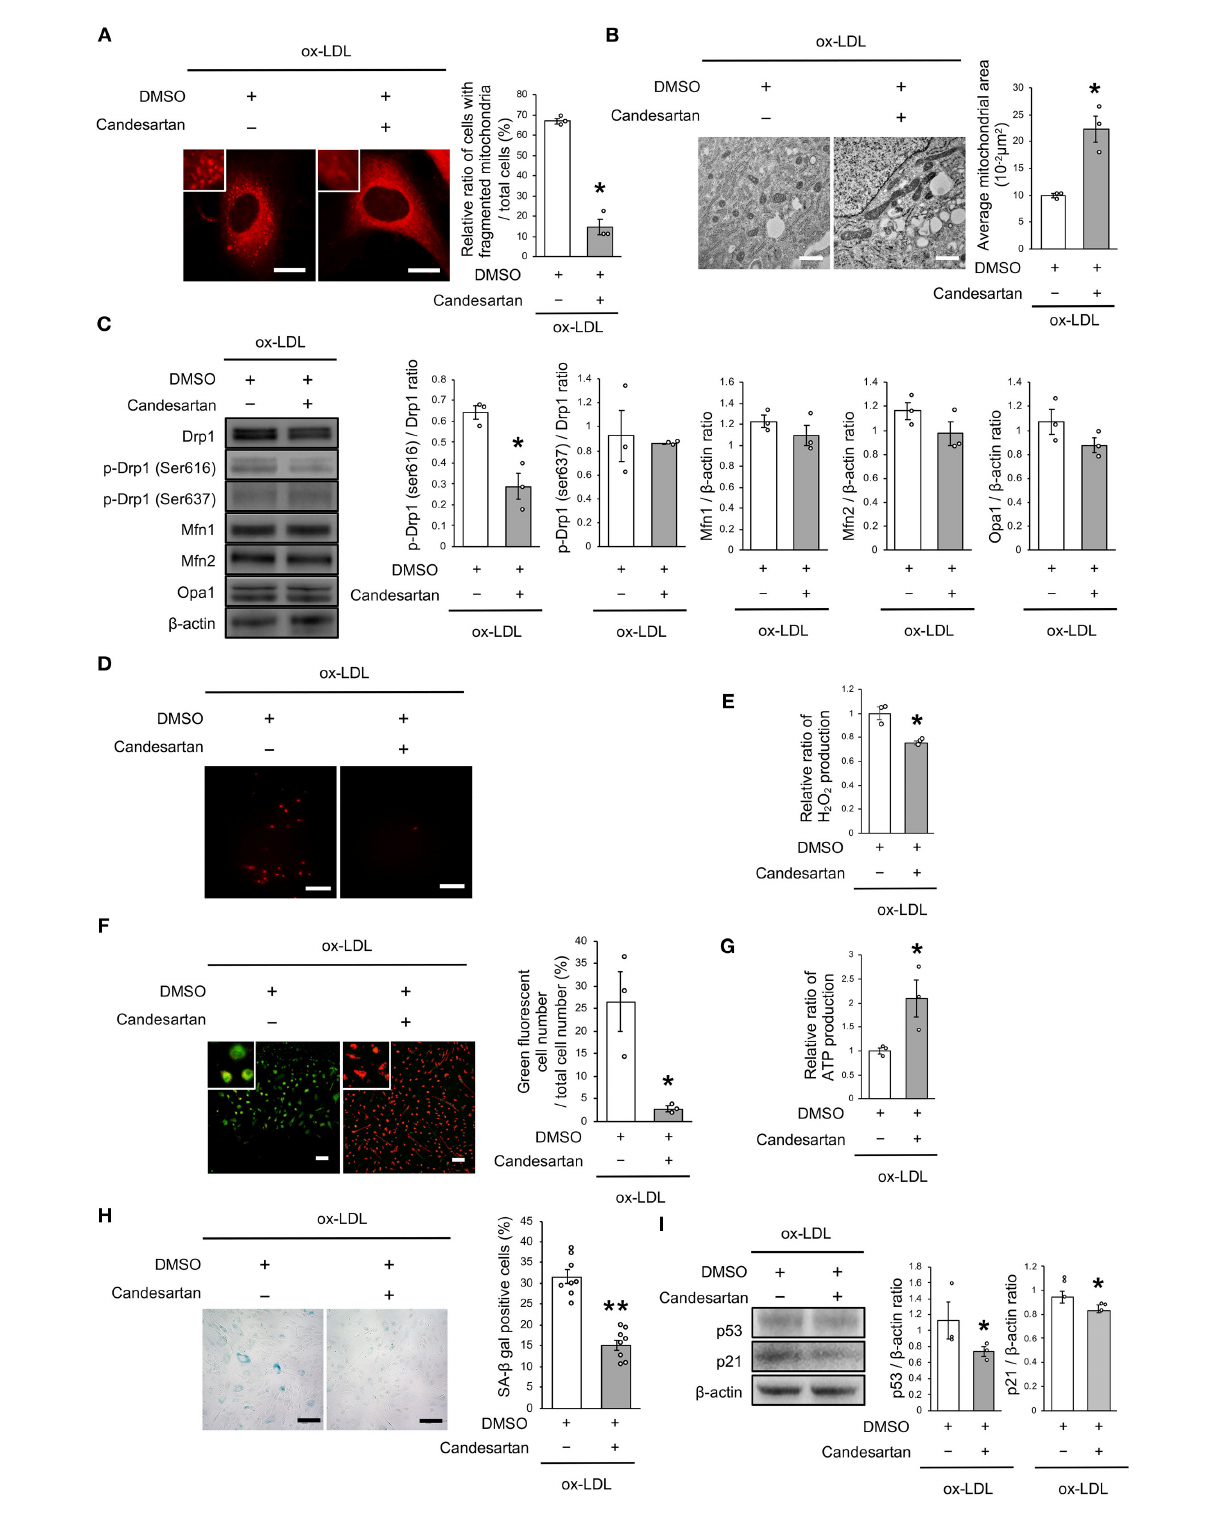
FIGURE 3 | AT1R inhibition retarded excessive mitochondrial fission, ROS production, mitochondrial dysfunction, and cellular senescence, which are induced by ox-LDL. (A) Representative images and quantitative analysis of Mitotracker Red in ox-LDL-treated cells with Candesartan or the control vehicle. Scale bar = 10 µ